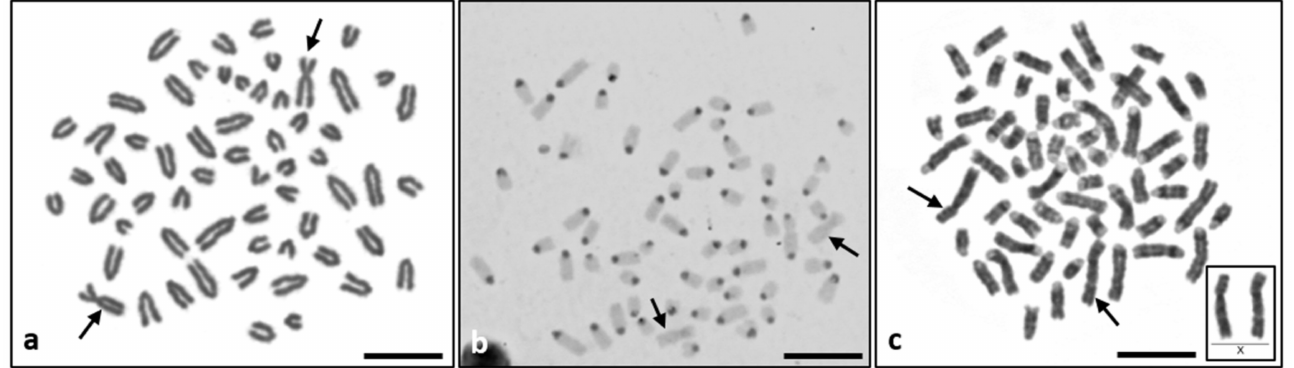
Figure 2. Representative metaphase spreads derived from in vitro leukocyte culture of DSD heifer #7514: ( a ) Giemsa staining—submetacentric X chromosomes are indicated by arrows, ( b ) C-banding—X chromosomes with no centromeric positive C band block are indicated by ar- rows, ( c ) G-banding—X chromosomes with normal patterns are indicated by arrows and enlarged in a right down corner. Scale bar = 10 µ